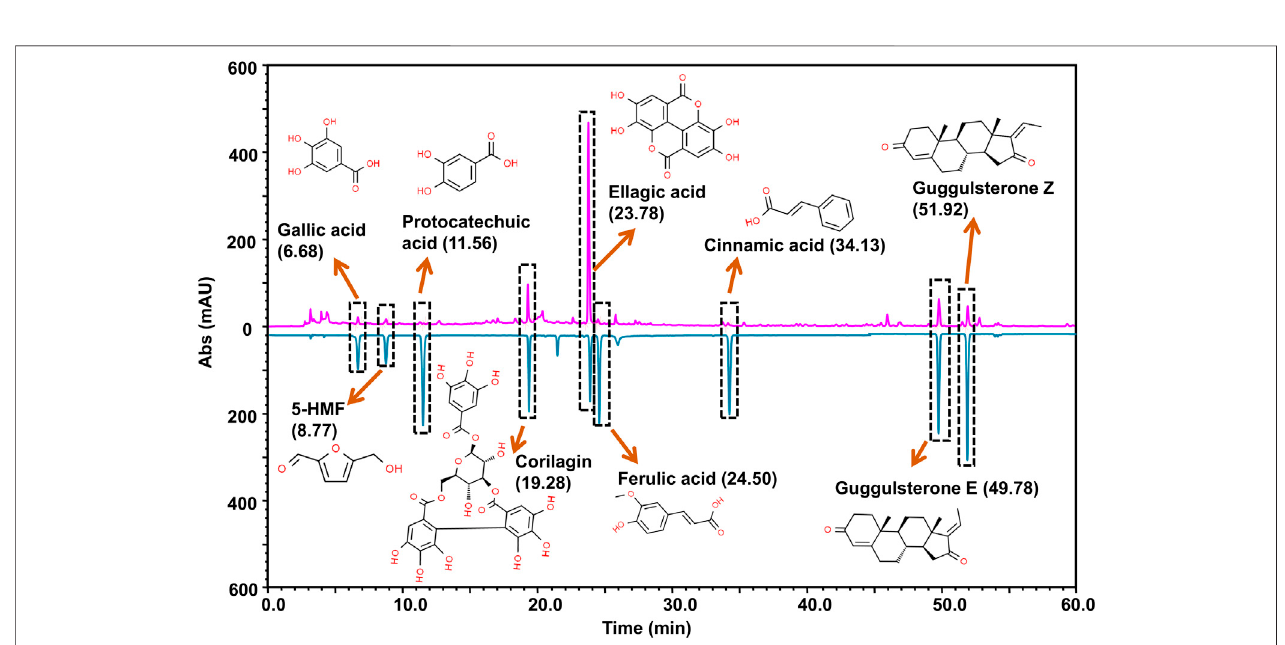
FIGURE 1 | Marker compound analysis. PN-G powder (chromatogram shown in pink) was subjected to UHPLC-PDA analysis by employing reference standards (chromatogram shown in blue). The chromatograms were recorded at 250 nm. By correlating the chromatograms vis-à-vis the pure analytical standards, UHPLC analysis detected the presence of nine marker phytocompounds in a 540 mg PN-G tablet, namely, gallic acid (7.5 µg), 5-(hydroxymethyl)furfural (45.5 µg), protocatechuic acid (6.0 µg), corilagin (21.5 µg), ellagic acid (1144.0 µg), ferulic acid (8.5 µg), cinnamic acid (11.0 µg), guggulsterone E (81.0 µg) and guggulsterone Z (70.0 µg). The chemical structures of the respective compounds are provided with the chromatogram.